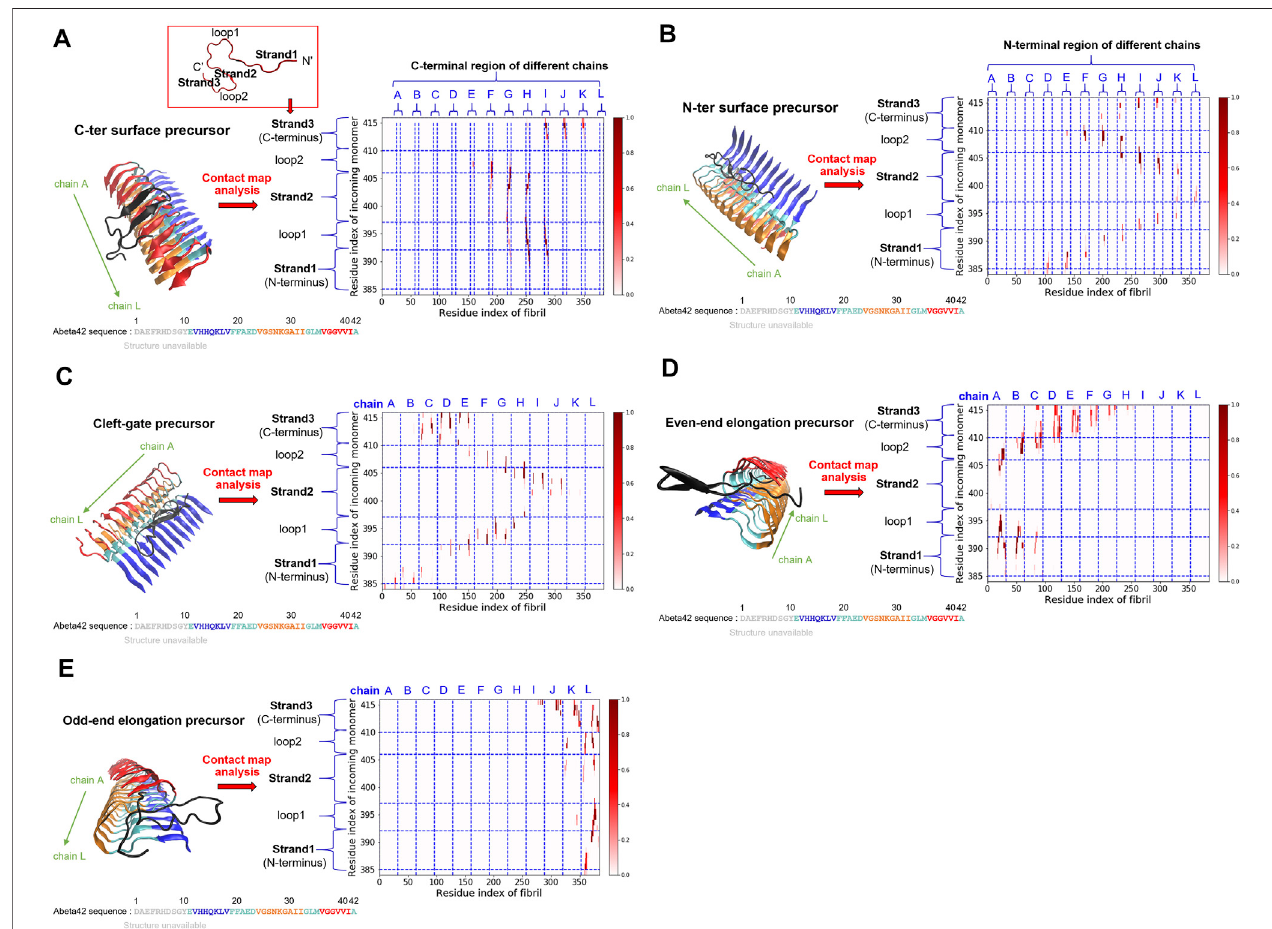
FIGURE 3 | Five key structural precursors on the fi brillar surface and their probability contact maps are shown. (A) C-ter surface precursor (B) N-ter surface precursor (C) Cleft-gate precursor (D) Even-end elongation precursor (E) Odd-end elongation precursor. The probability contact map next to each structural precursor presents the contacts formed between the monomer and the fi bril. The colorbar, scaled by probability, is shown on the right. The horizontal axis uses the fi bril index (1 – 384;32 × 12 (cid:1) 384),whichsequentiallyrenumbersthe12monomersinthe fi bril.Theverticalaxisdescribestheresidueindexofthefreemonomerbyaddingup theexisting fi brilindex,385 – 416(384+32 (cid:1) 416).Differentstructuralfeaturesarelabeledas “ strand ” or “ loop ” .Notethatin (A) ,aschematicmonomerstructureisshown in a red box, with its structure in the fi brillar form. Three strands (strand 1, 2, and 3) and two loops (loop 1 and 2) are indicated. The color scheme for the structure is the same as that used in Figure 1 .